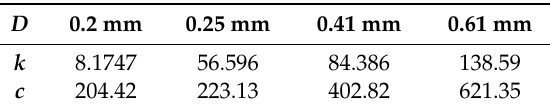
Table 3. The identified coefficients of the linear models. D is the inner diameter of nozzle; k and c are the slope and offset of the linear relationship.